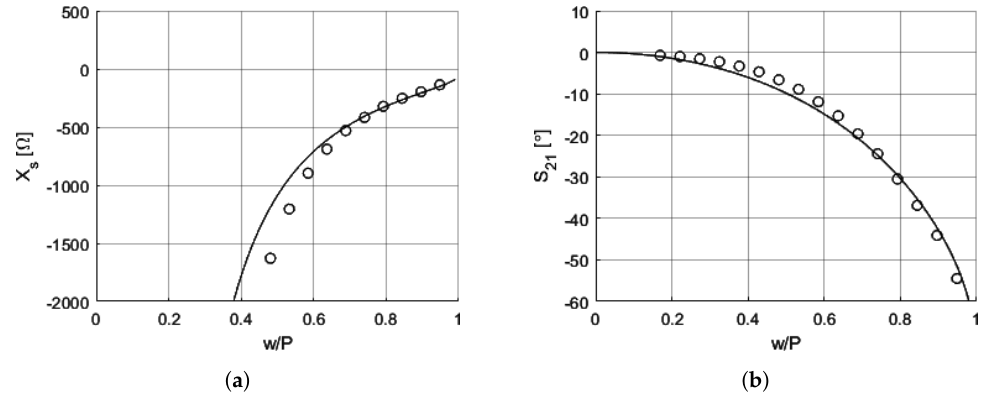
Figure 7. Performance of patch unit cells. Lines are analysis, points simulation results. ( a ) Surface reactance; ( b ) phase shift.